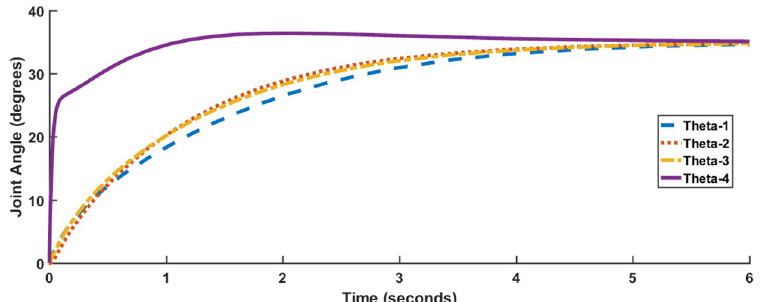
Fig 10. SFG-MIMO PI response, Case I.